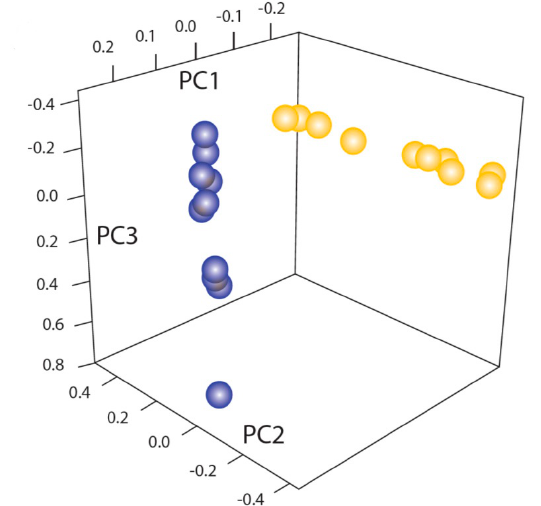
Figure 9. Principal component analysis of the genomic sequence of C. immitis and C. posadasii strains. The blue points represent DNA sequence of C. immitis strains; the yellow points represent DNA sequence of C. posadasii strains. The figure is from [120] .